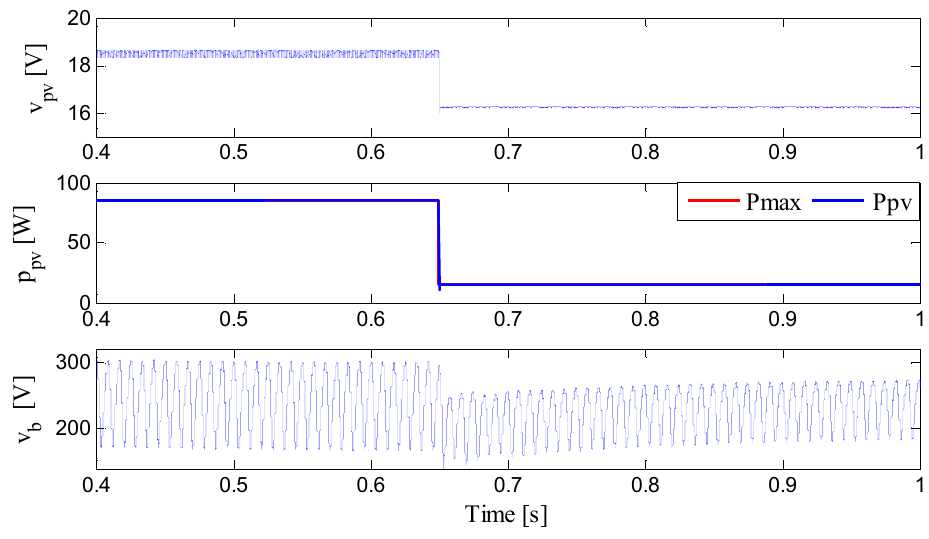
Figure 16. SMC behavior interacting with a grid-connected inverter.